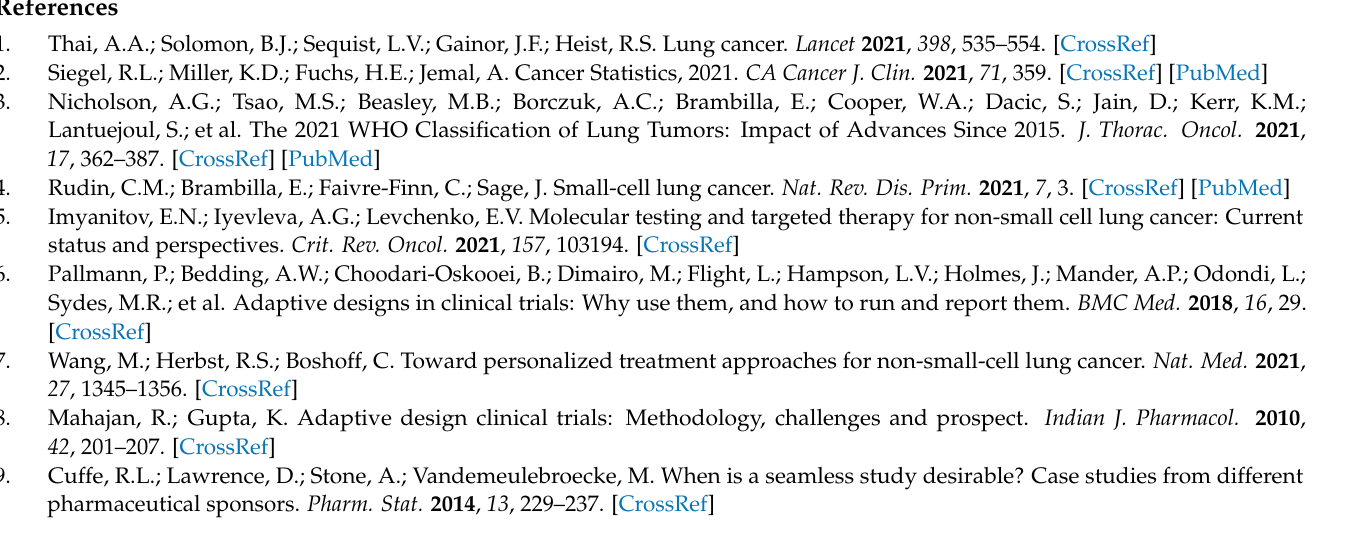
Table S9: Dose escalation Phase II/III trials (Additional characteristics); Table S10: Multi-Arm Multi Stage (MAMS) phase II/III trials (Additional characteristics); Table S11: Multi-Arm Multi Stage (MAMS) phase II/III trials (Additional characteristics); Table S12: Trials with other design (Addi- tional characteristics); Table S13: Trials with other design (Additional characteristics); Table S14: Detailed Cochrane risk-of-bias tool for randomized trials (RoB 2) assessment. Author Contributions: All authors contributed to the study conception and design. Material prepara- tion, data collection and analysis were performed by D.P. and I.N.-S. The first draft of the